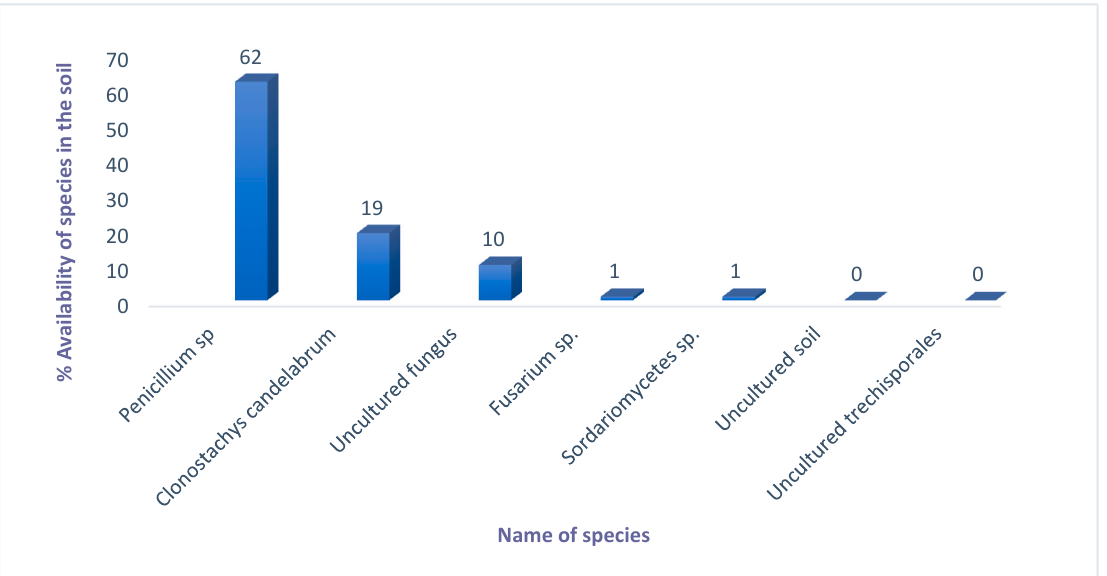
Figure 3. Representation of fungal species in Burkea soils.